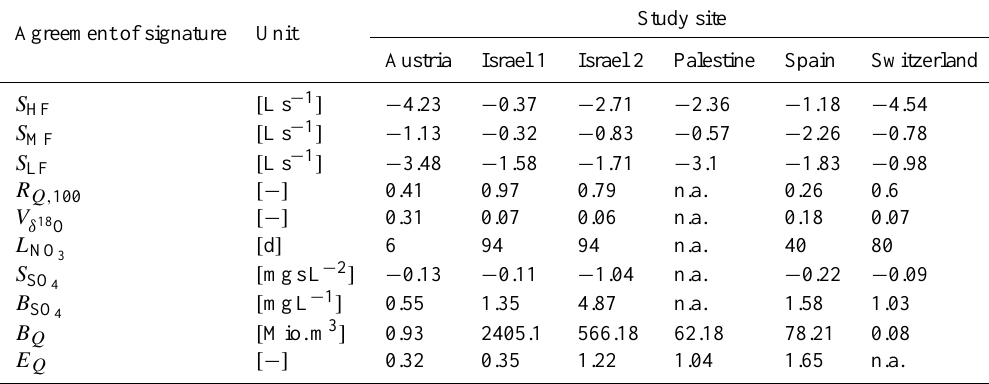
Table 5. Observed karst system signatures obtained by the signature equations provided in Table 3. Agreement of